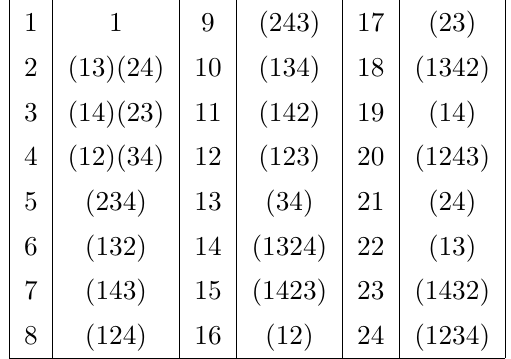
Table 13 . Assignments of transpositions to S 4 element numbers in tables 11,